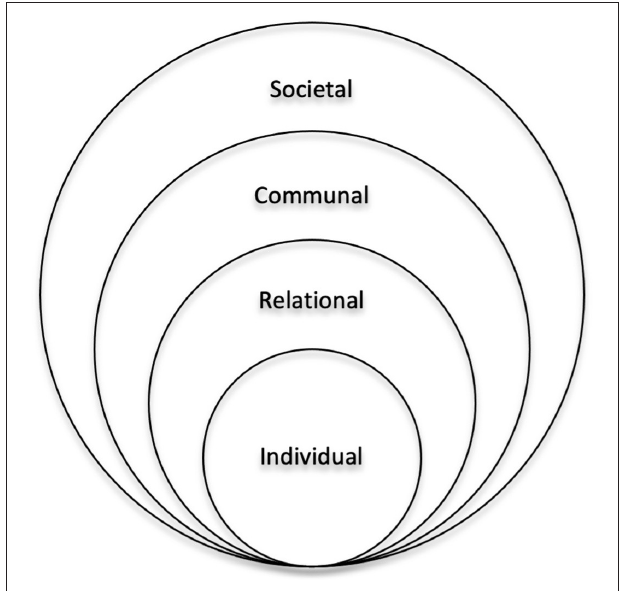
FIGURE 2 | The social ecological model for understanding the cause of intimate partner violence.